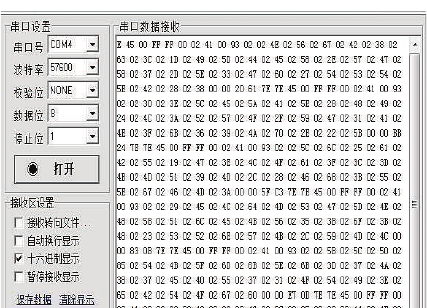
Figure 16: Interface of the serial